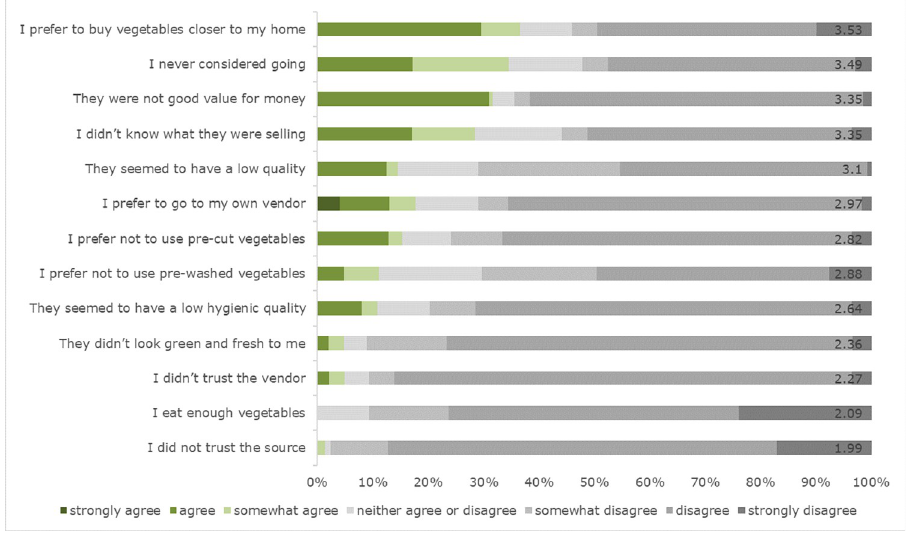
Fig 2. Reasons for not buying GLV from the intervention near workplaces at FUTA university and (state) secretariats (N = 295) in percentages and mean values added at the end of the